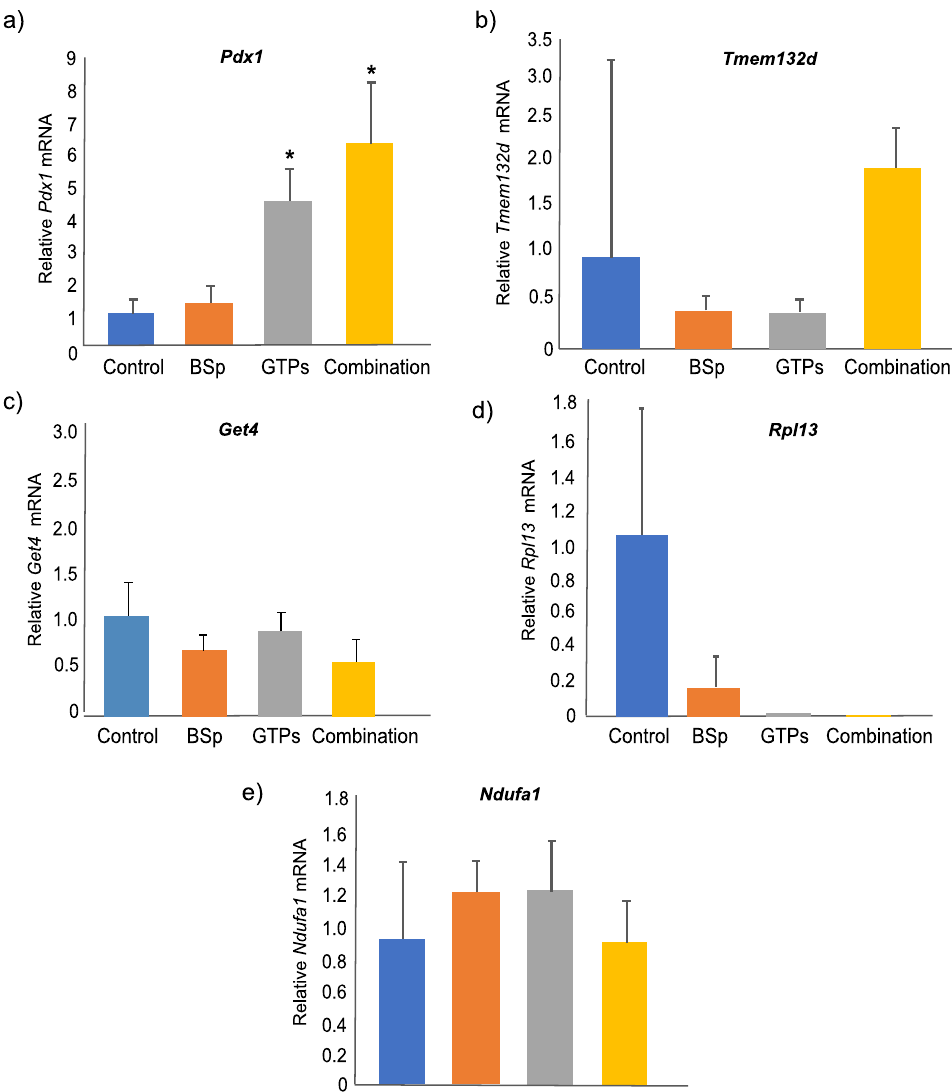
Figure 7. Validation of unique differentially expressed and differentially methylated genes in combination (BSp + GTPs) treatment group using quantitative real-time PCR to measure relative expression of ( a ) Pdx1 ( b ) Tmem132d ( c ) Get4 ( d ) Rpl13 and ( e ) Ndufa1 in BSp, GTPs and the combination (BSp + GTPs) treatment groups. The experiments were performed in triplicate from three independent experiments and further normalized to internal control and calibrated to levels in control (untreated) samples. Columns mean; bars, standard error. *p value <